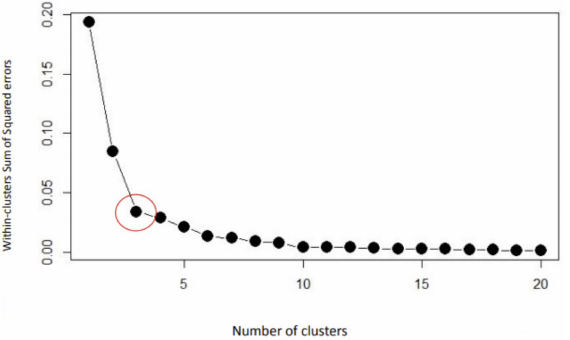
Figure 1. Determination of optimal cluster number. The optimal number is visualized by the inflection point that corresponds to three clusters, as shown by the red